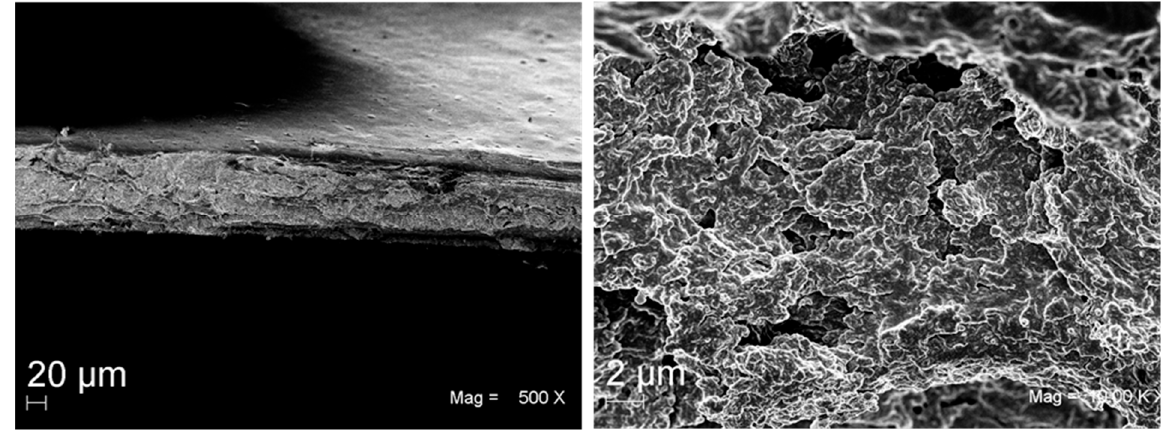
Figure 6. SEM image of the R10 fraction.